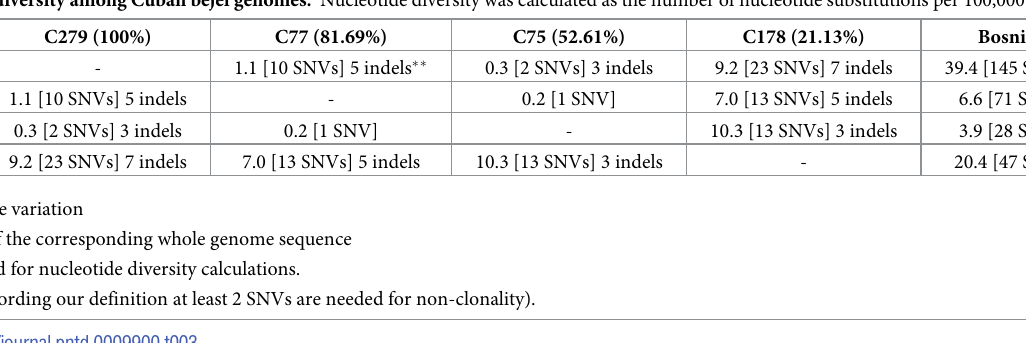
Table 3. Nucleotide diversity among Cuban bejel genomes. Nucleotide diversity was calculated as the number of nucleotide substitutions per 100,000 bp.